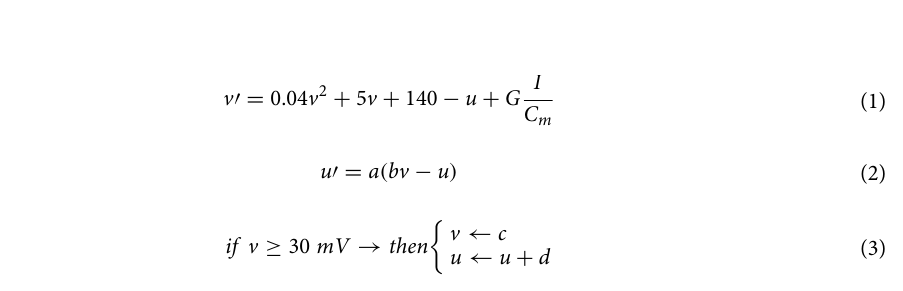
Table 2. Parameter values of the Izhikevich neuron model in regular spiking